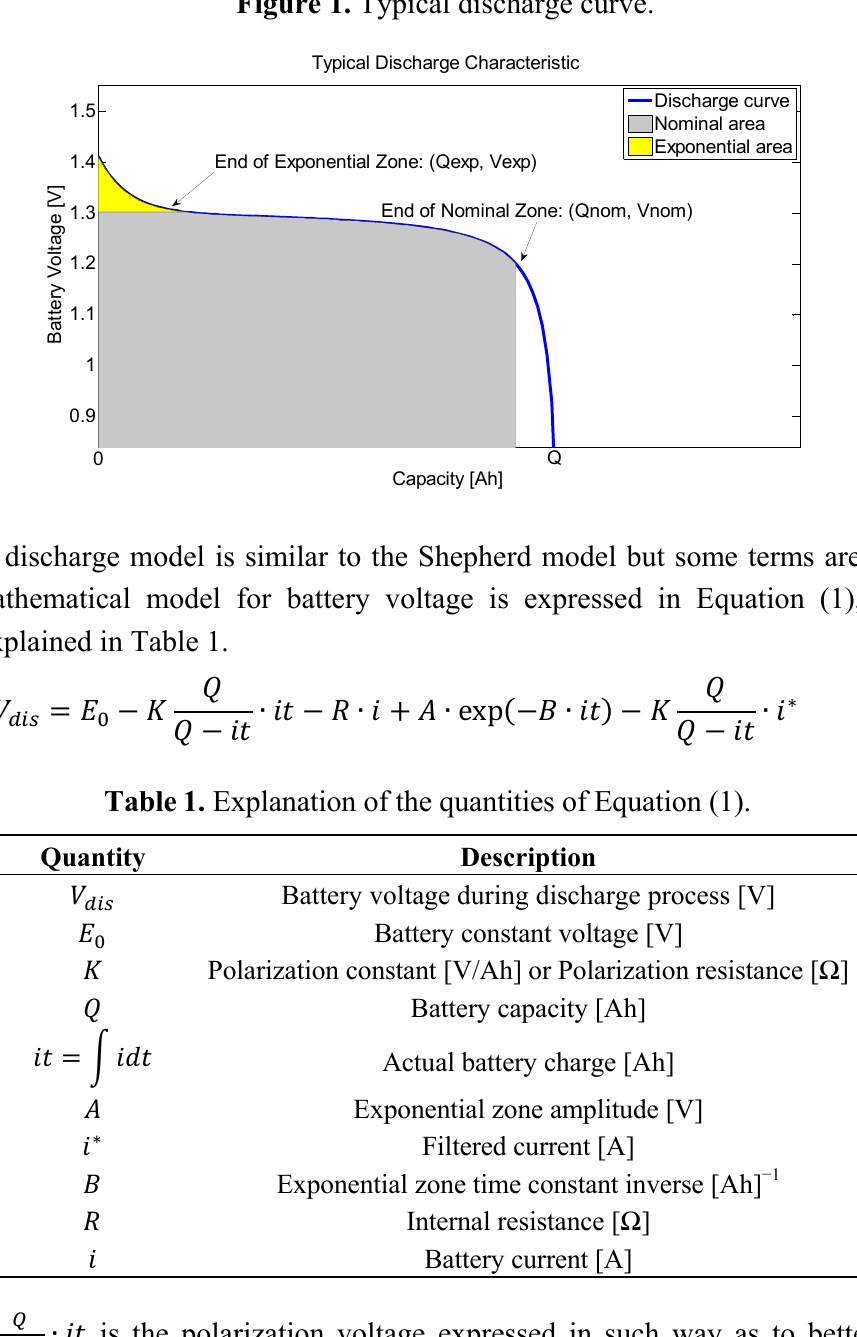
Figure 1. Typical discharge curve.